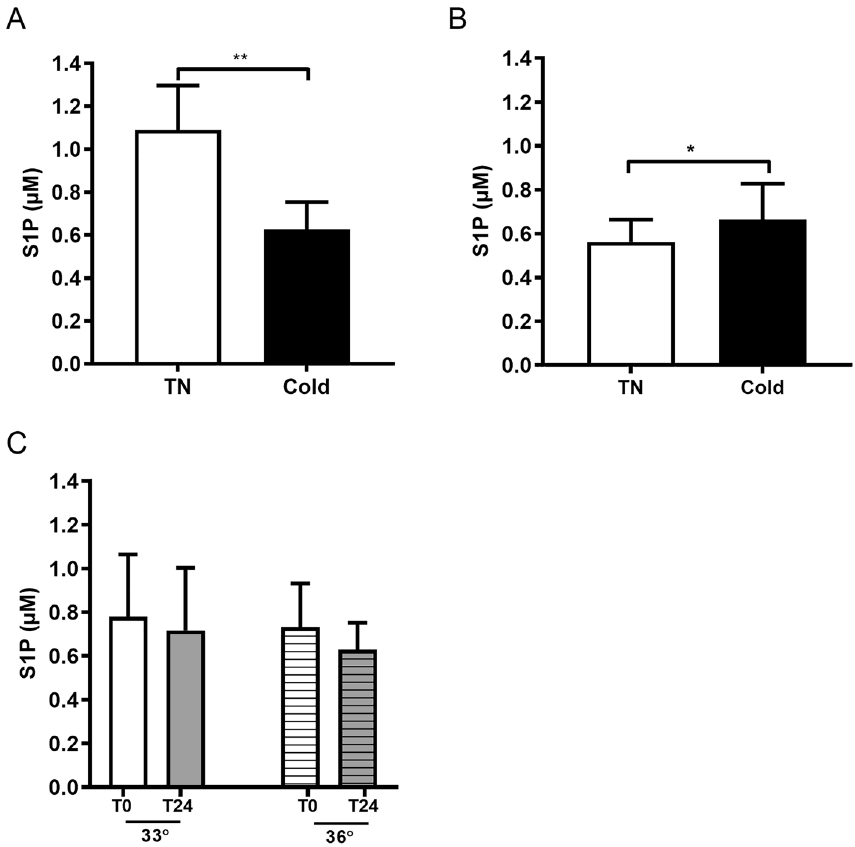
Figure 4. S1P plasma levels in STC-CPH (A), STC-LEI (B), and LTC (C). Thermoneutral (TN) and cold refers to pre-cooling and after cold exposure (2 h) in STC-CPH (n = 15) and STC-LEI (n = 20). In LTC samples were taken at 0 and after 24 h at either 33˚C (n = 20, intensified cold) or 36˚C (n = 24, cold maintenance). Data presented as mean with error bars as SD and in A and B and analyzed with either a paired t-test or Wilcoxon signed-rank test depending on a normal distribution. In C data are analyzed with a two-way mixed ANOVA with time and temperature as variables. * P < 0.05, ** P < 0.01, *** P < 0.0005 for TN vs Cold. STC-CPH; short-term cold, Copenhagen. STC-LEI; short-term cold, Leiderdorp. LTC; long-term cold.